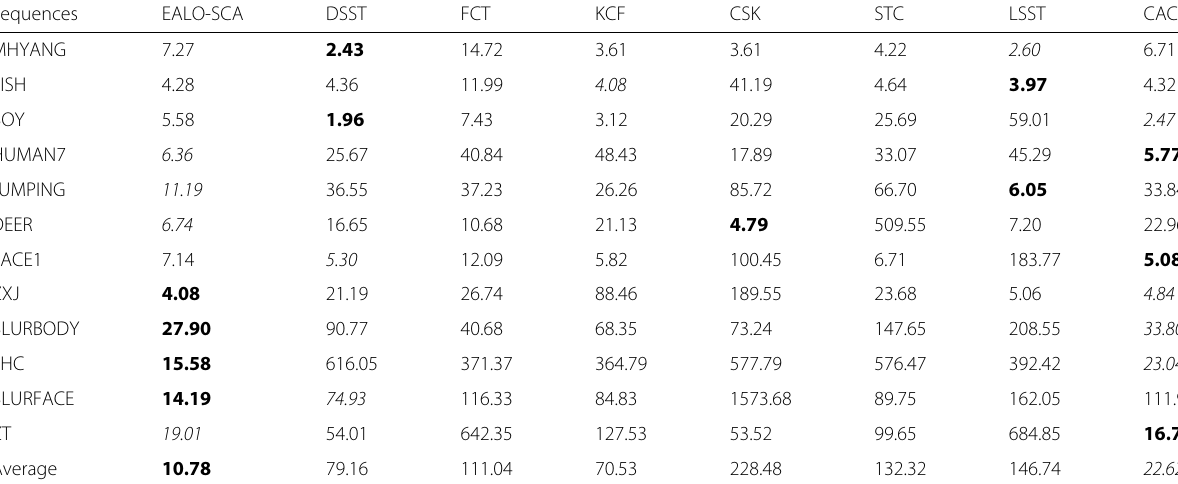
Table 3 Average center error